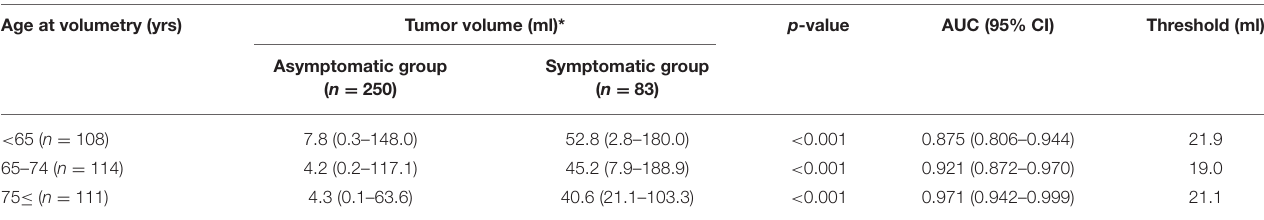
TABLE 2 | Comparison by age at the time of volumetric